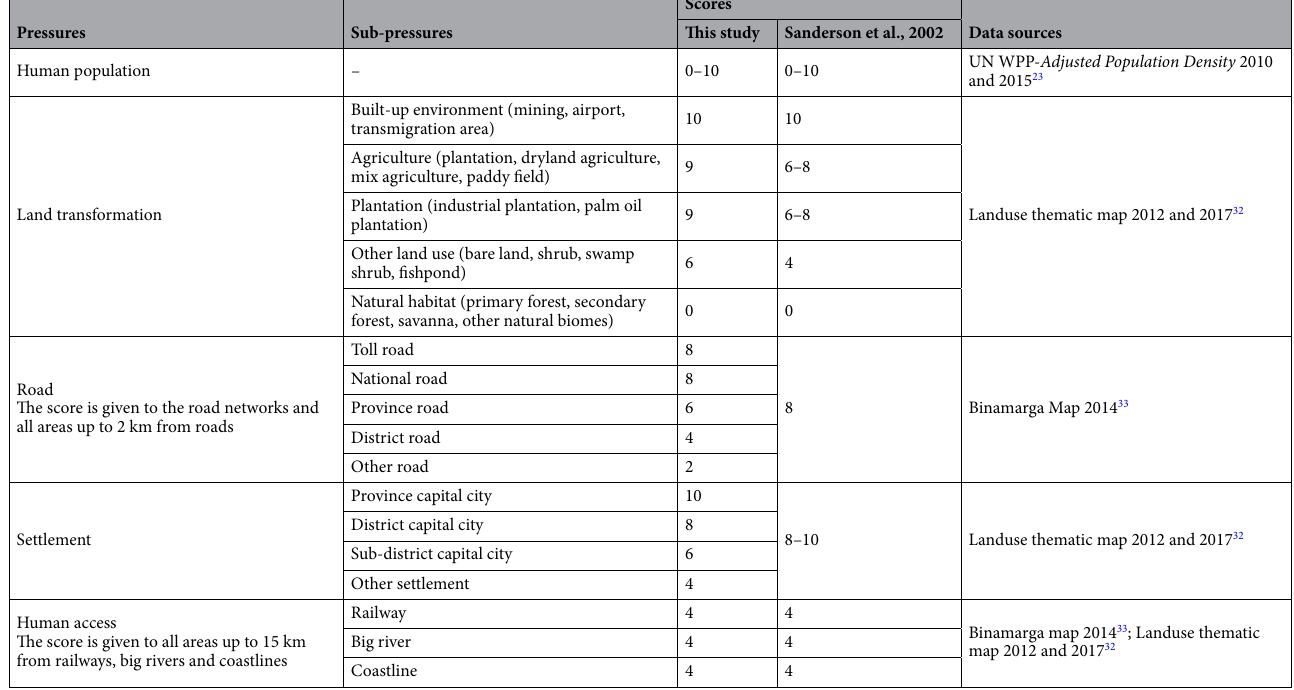
Table 2. Relative scores for pressures inside national parks and in 10 km buffers outside the parks used in the Human Footprint